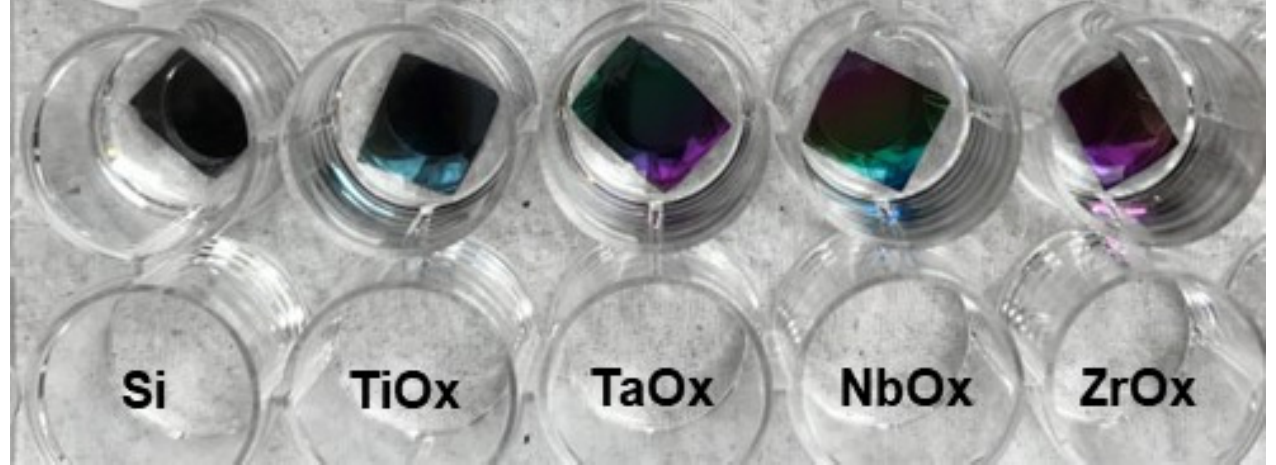
Figure 1. Representative pictures of the macroscopic appearance of Si (100) wafers coated with metal oxide thin films by magnetron sputtering. Coated samples were named as TiOx, TaOx, NbOx, ZrOx, for titanium, tantalum, niobium and zirconium oxide coatings, while Si samples correspond to uncoated Si (100) wafers.